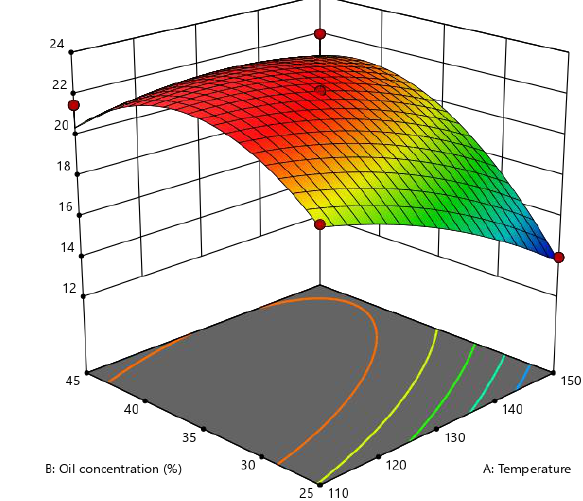
Figure 10. Three-dimensional contour plots generated by Design Expert (Stat Ease, Inc.) of the significantly interacting model terms A: Temperature ( ◦ C) and B: Oil concentration ( v / v )%.